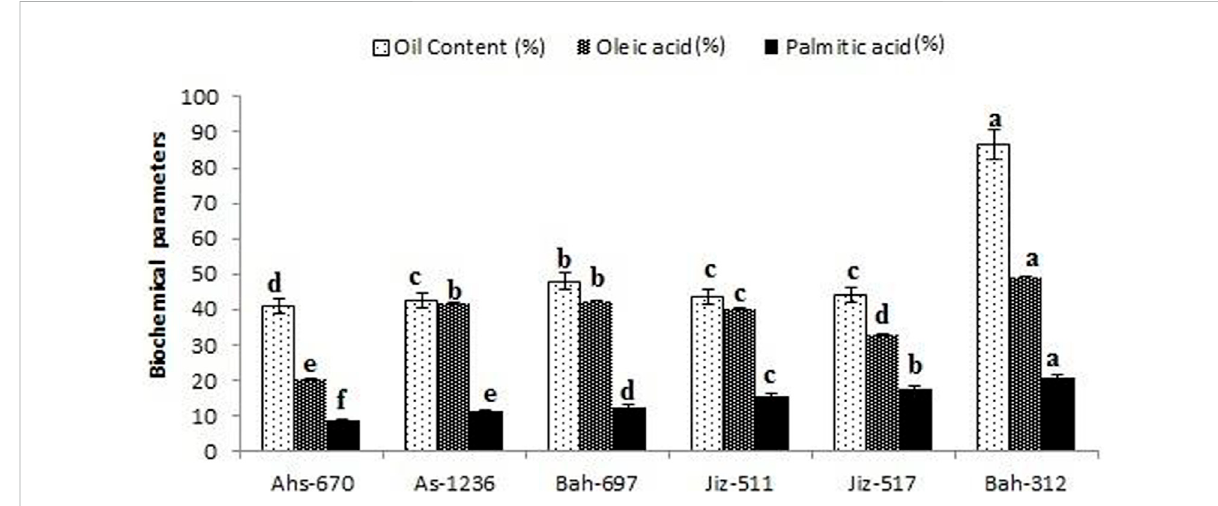
FIGURE 2 Percentage of oil content and fatty acids content (Oleic acid & Palmitic acid) for different sesame genotypes. Values are the average of three replicates ±SD. Different letters indicate signi fi cant differences according to Duncan ’ s multiple range tests ( p < 0.05 ).